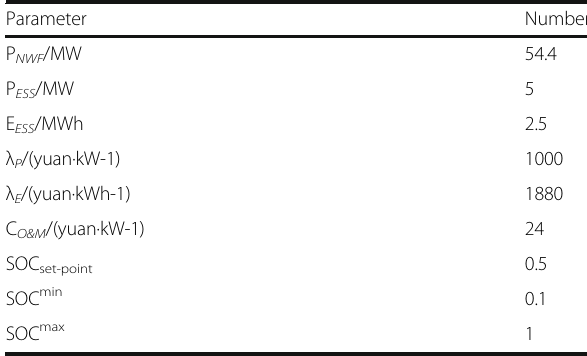
Table 1 The LiFePO4 battery ESS System installed capacity and the power/capacity parameters